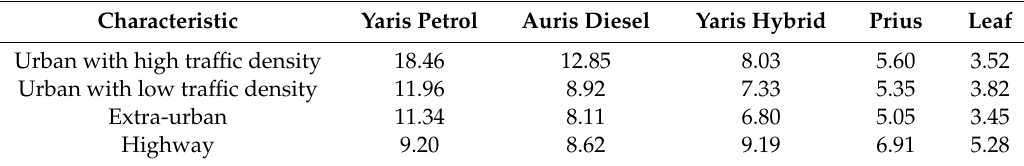
Table 3. Energy vectors cost (c € /